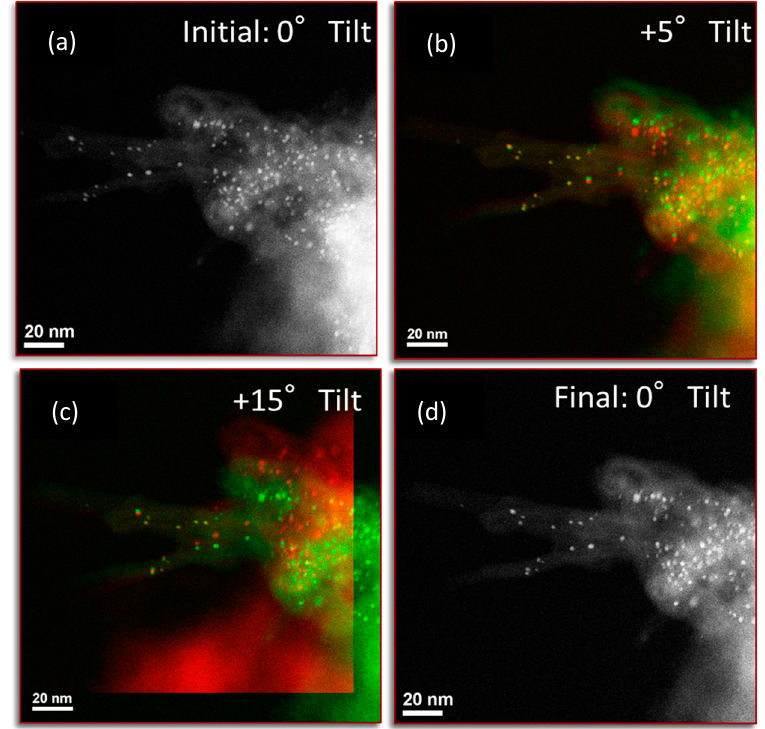
Figure 5. STEM images for 11.1Pt/ MWCNT II COOH showing ( a ) Initial- no tilt; ( b ) +5° tilt; ( c ) +15 tilt; and ( d ) Final-no tilt.